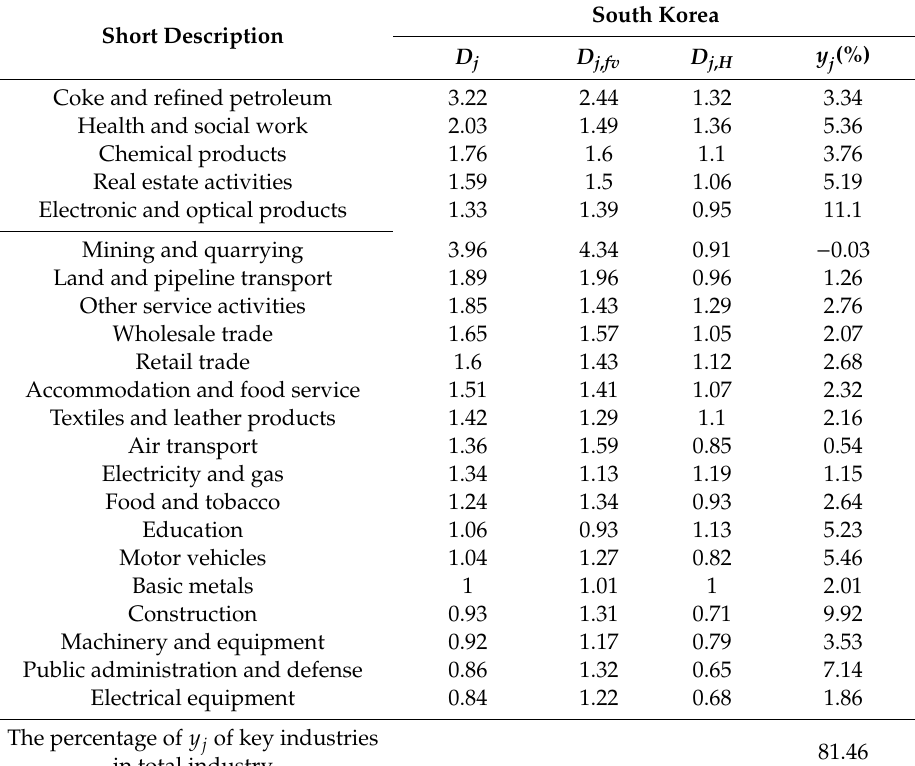
Table 6. Multiplicative SDA of EEI di ff erence of key sectors in South Korea in